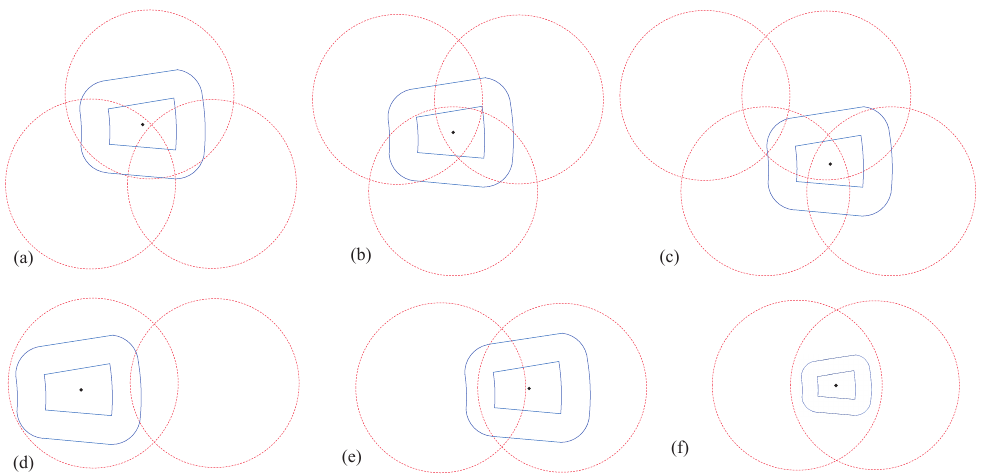
Figure 6. Target area and BS coverage area.